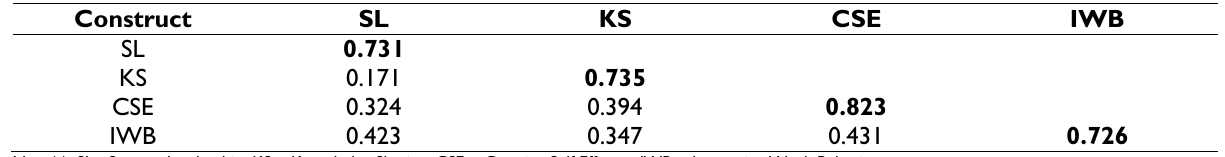
Table 4. Discriminant